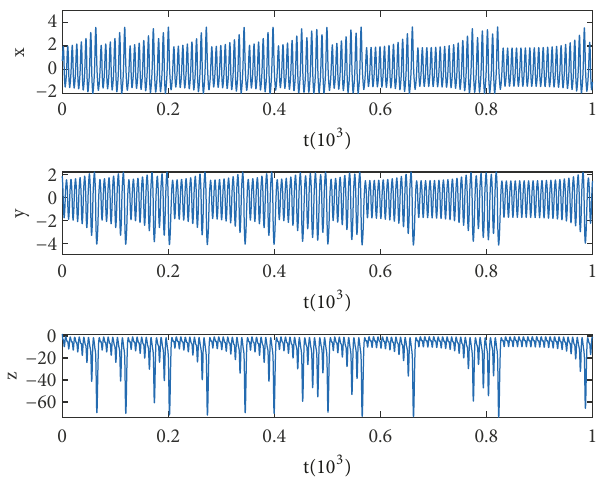
Figure 3: Time series diagram of system (1) ( 𝑥(𝑡) , 𝑦(𝑡) , 𝑧(𝑡)